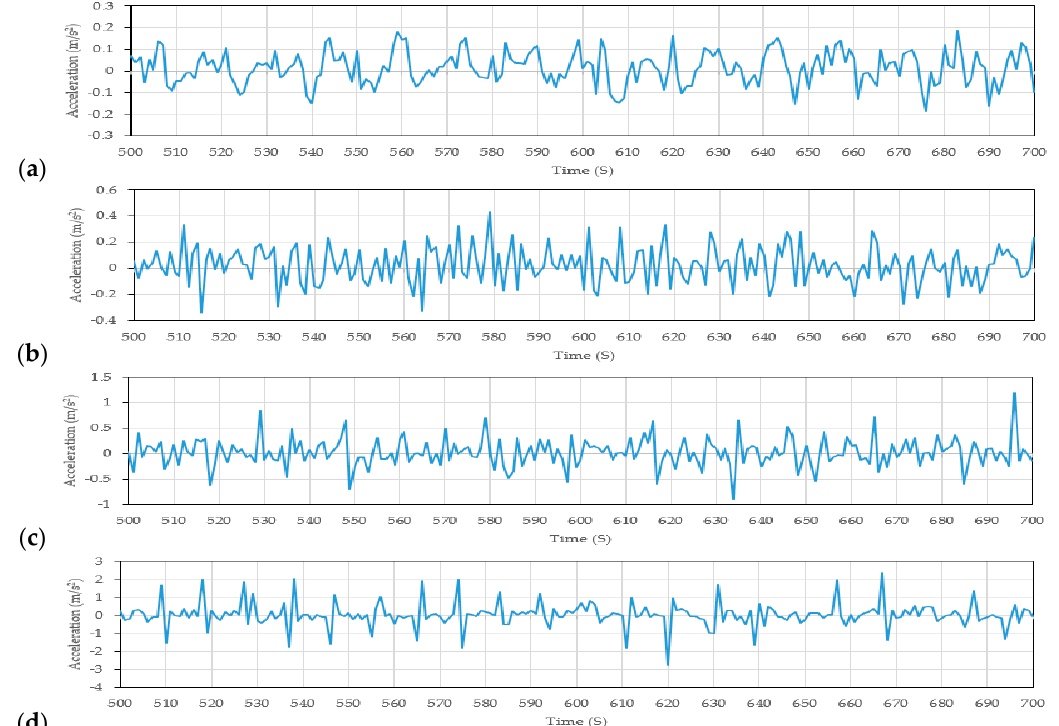
Figure 3. A closer view of acquired vibration signal for different bearing conditions. ( a ) No ‐ Fault; ( b ) Inner Race Fault; ( c ) Outer Race Fault; ( d ) Ball Fault.